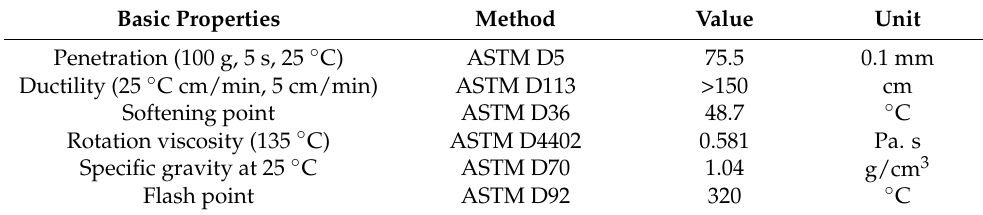
Table 1. Basic properties of the asphalt.